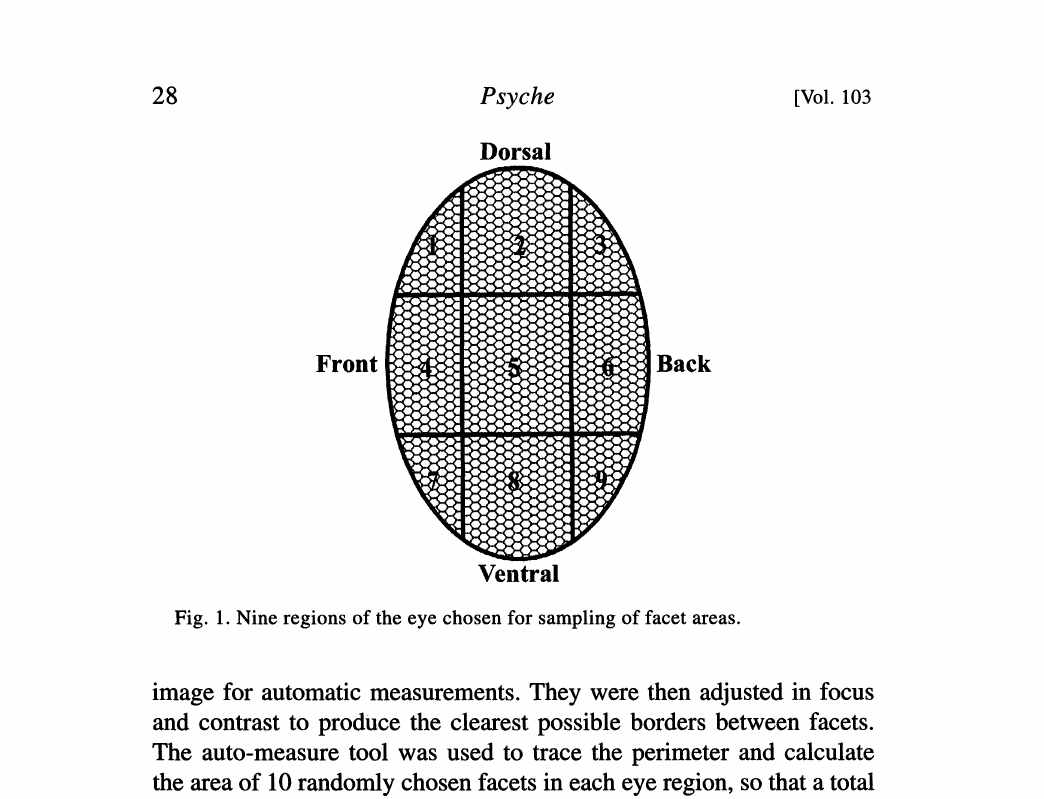
Fig. 1. Nine regions of the eye chosen for sampling of facet